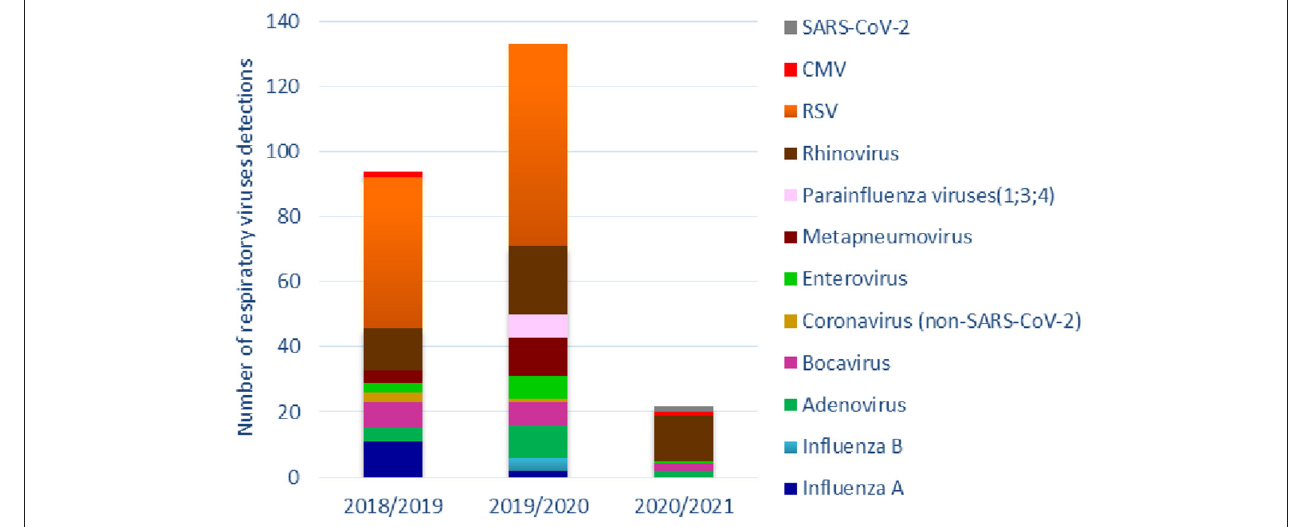
FIGURE 1 | Cumulative respiratory viruses detections by year and viral